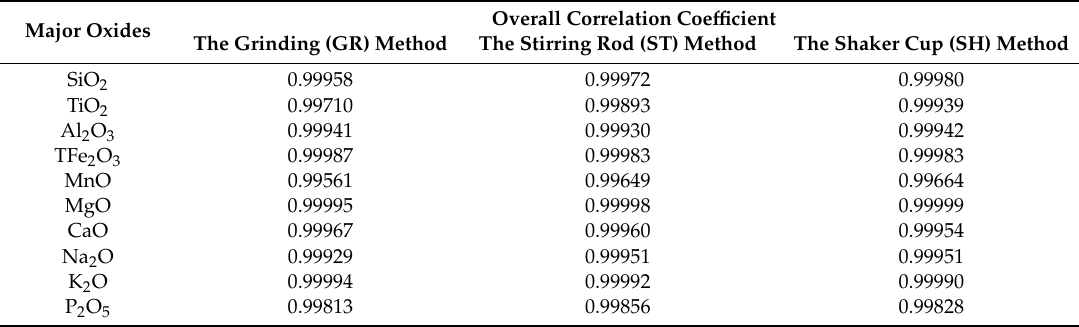
Figure 4. Representation of the measured and recommended values for the major oxides (letters ( a ), ( b ), and ( c ) represent the grinding (GR), stirring rod (ST), and shaker cup (SH) methods, respectively). Table 3. Results of the overall correlation coe ffi cients between the measured and recommended values of the major